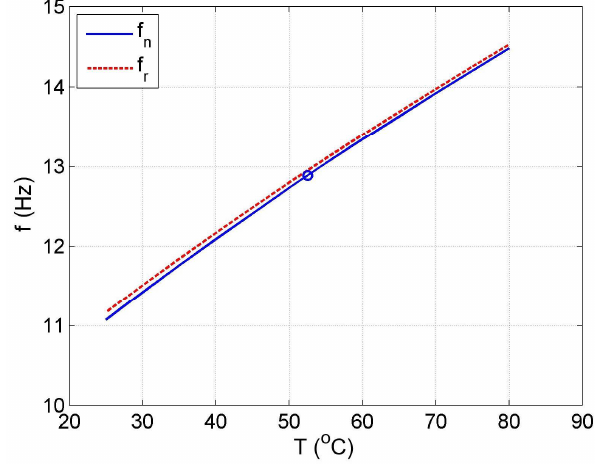
Figure 16. Chart of the natural frequency f n (solid line) and the resonance frequency f r (dashed line).